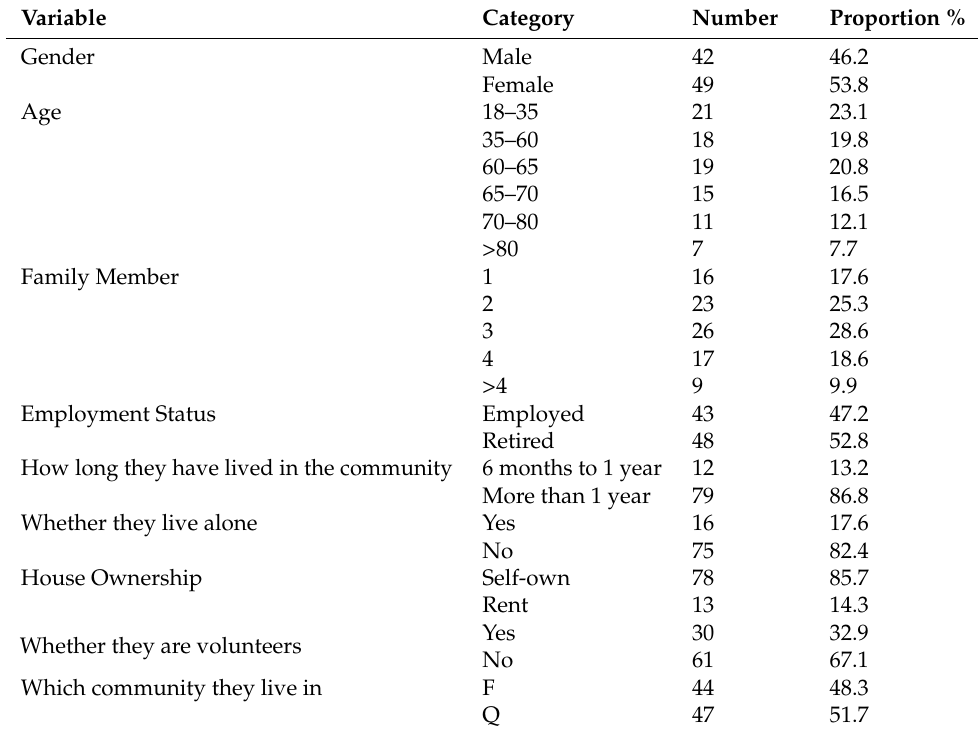
Table 1. Sociodemographic information for resident